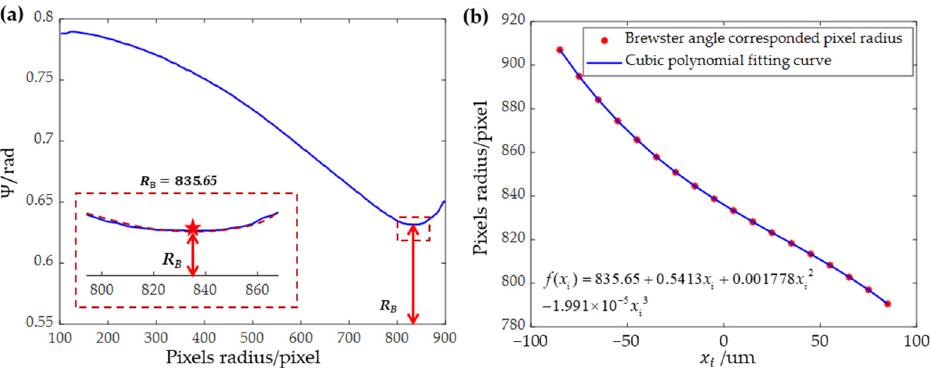
Figure 7. Incident angle calibration experiment with a standard thick K9 glass plate: ( a ) the calculated angle-resolved Ψ and Ψ min corresponding to pixel radius R B ; ( b ) the relationship between Brewster angle corresponding to pixel radius R B of defocus position x i